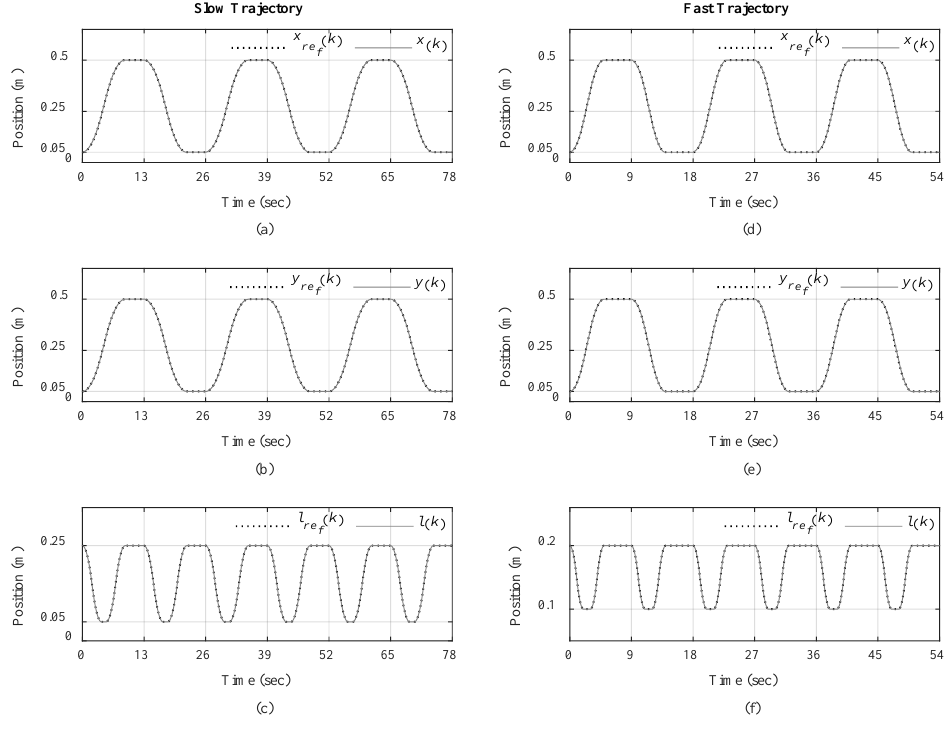
Figure 8. Actual and reference trajectories: ( a ) Traveling; ( b ) traversing, and ( c ) hoisting for slow trajectory; ( d ) Traveling; ( e ) traversing, and ( f ) hoisting for fast trajectory under Scenario III.